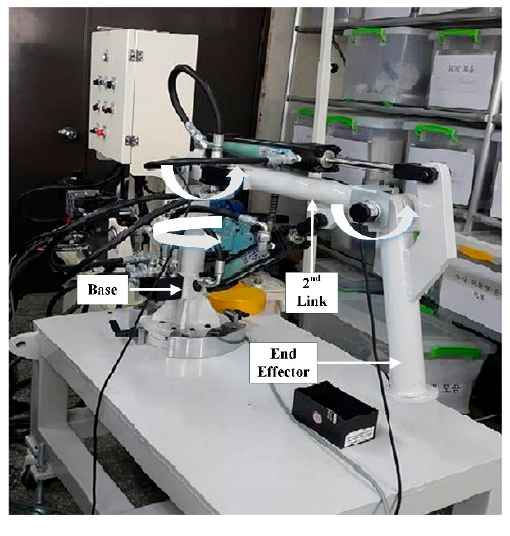
Figure 7. Slave device. Table 1. Hydraulic manipulator specifications.